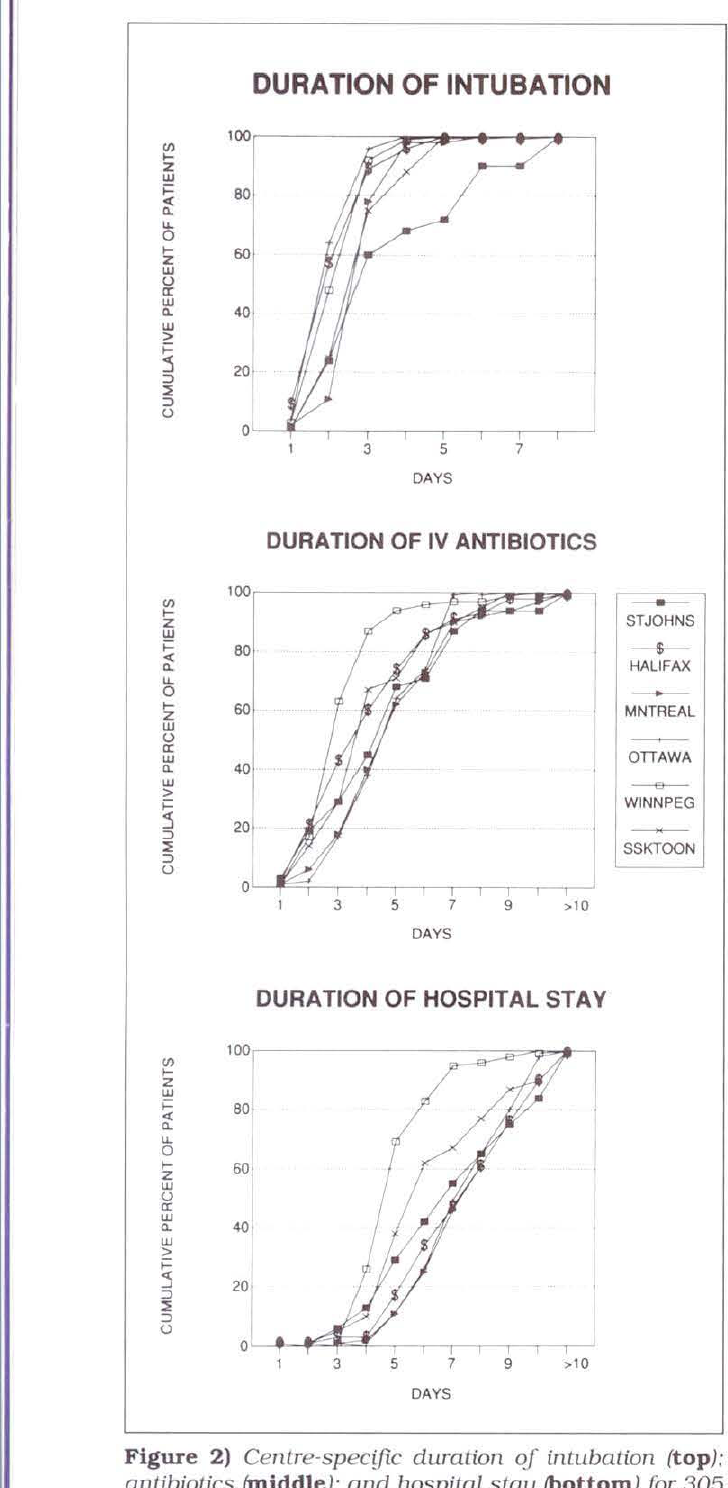
Figure 2) Centre-spec(fic duration of intubation (top): antibiotics (middle): and hospital stay {bottom) for 305 childr·en w ith acute epigloltitis. The signiJ'icant di.[feren ces between centres for each parameter are discussed